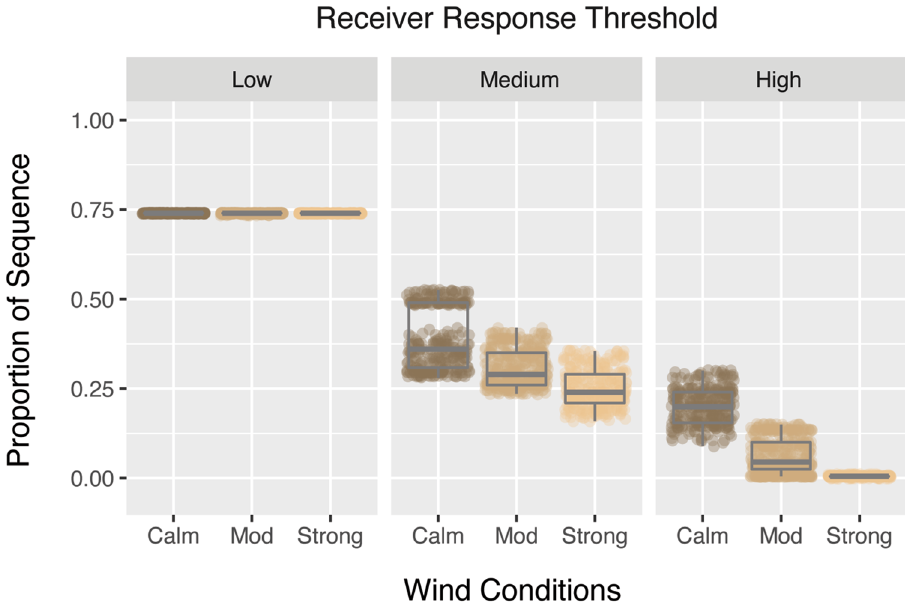
Figure 4. The performance of A. muricatus in its own habitat as a function of wind conditions and receiver response threshold. The y-axis indicates the proportion of the sequence exceeding a given threshold, with separate plots for low (0–0.3), medium (0.3–0.8) and high (0.8–1) thresholds and wind conditions on the